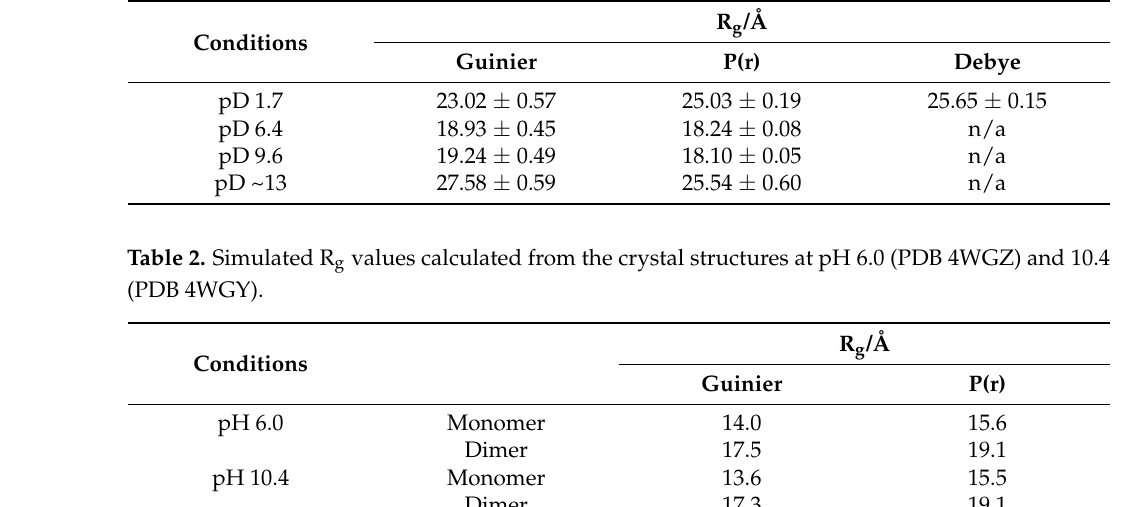
Figure 3. Guinier analysis (top panels) and P ( r ) function (bottom panels) of Cyt c ’ at pD 1.7 ( A ), 6.4 ( B ), 9.6 ( C ), and ~13 ( D ). The linear regions of the Guinier plots used in the analyses are shown as red solid lines. Table 1. Estimated R g values from experimental SANS curves.